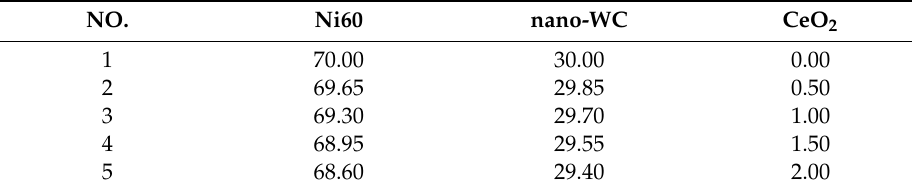
Table 3. Cladding material ratio (wt. %).